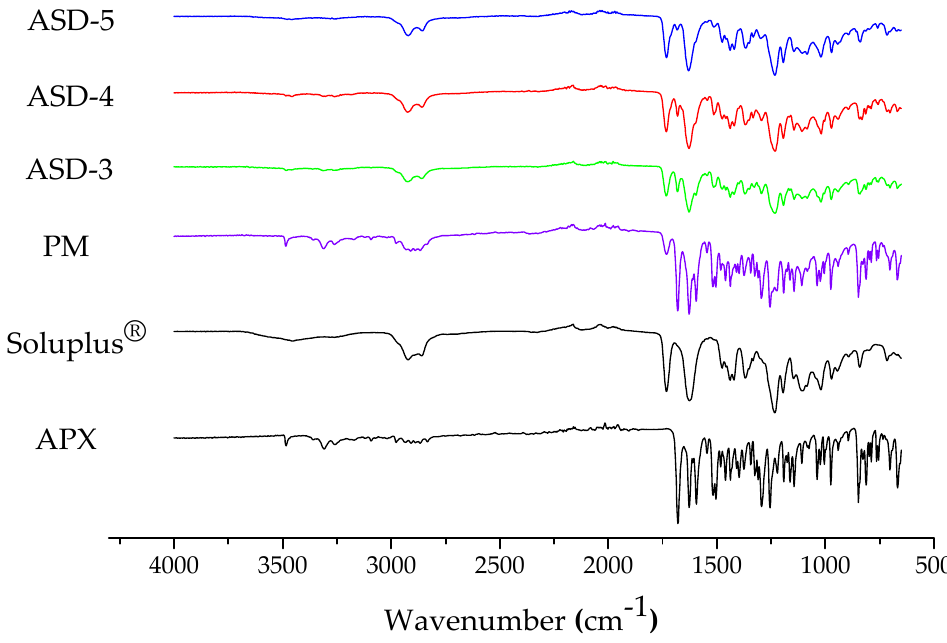
Figure 3. FT-IR spectra of APX, Soluplus ® , PM, and ASD-3, ASD-4, and Figure 2. FT-IR spectra of APX, Soluplus ® , PM, and ASD-3, ASD-4, and ASD-5.